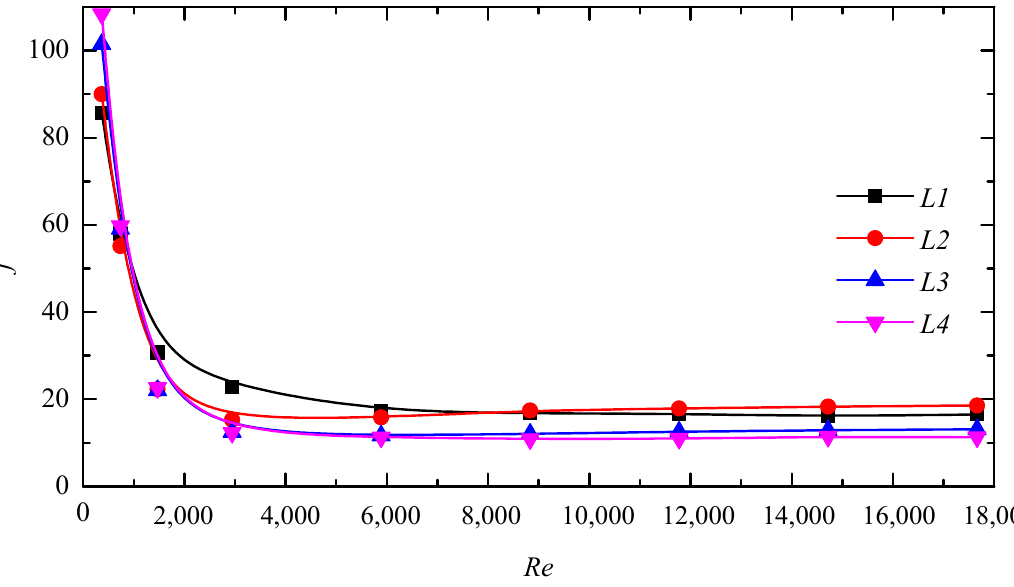
Figure 11. The variation offriction factor versus Reynolds number in different wavelengths.